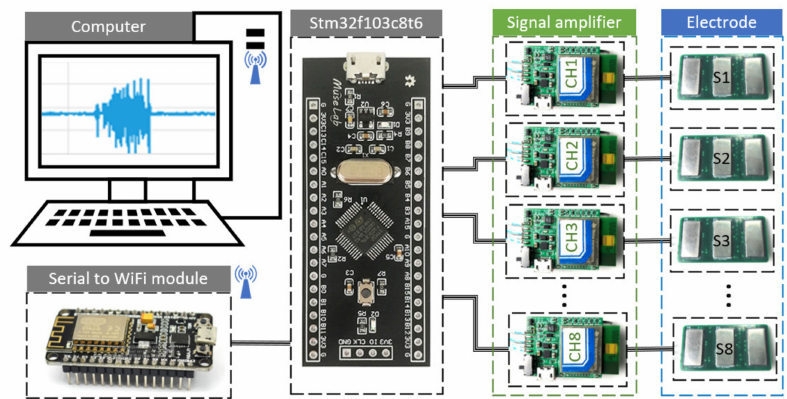
Figure 2. Hardware of the wireless surface electromyography (EMG) acquisition